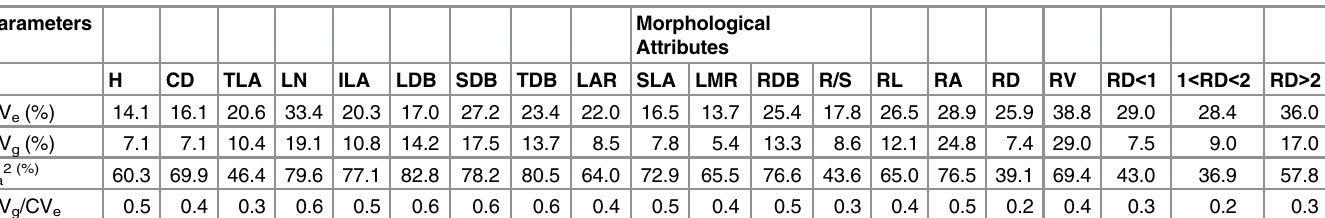
Table 3. Estimates of genetic parameters for shoot and root morphological attributes used in the analysis of cacao genotypes contrasting for drought tolerance submitted for 60 days to two water conditions (SI): Control ( Ψ WL between -0.1 and -0.5 MPa) and stressed ( Ψ WL between -2, 0 – 2.5 MPa). Ilhéus, Bahia, Brazil.